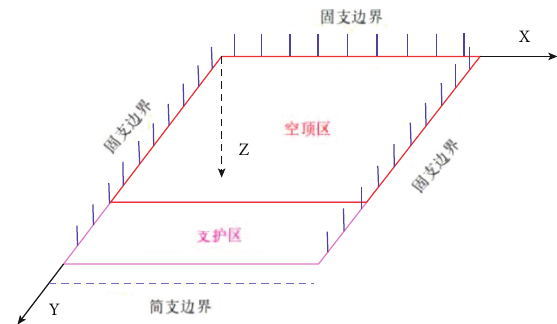
Figure 2: The boundary state of the roadway roof.